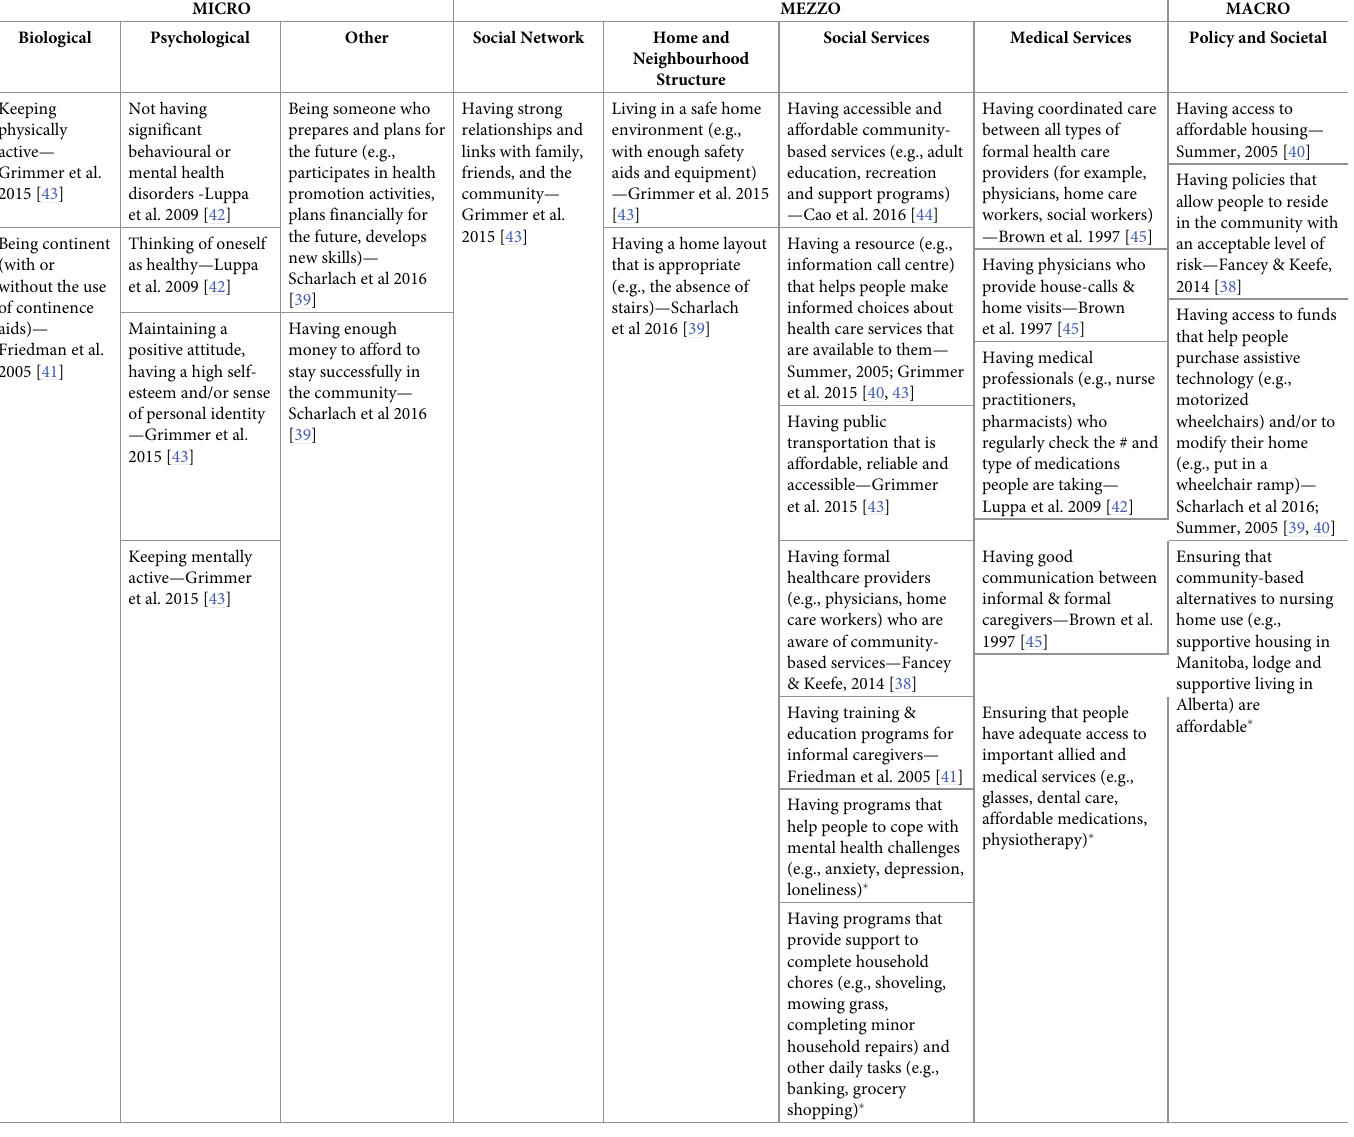
Table 1. Survey factors by source, and categorized by the Health-Related Safety Framework